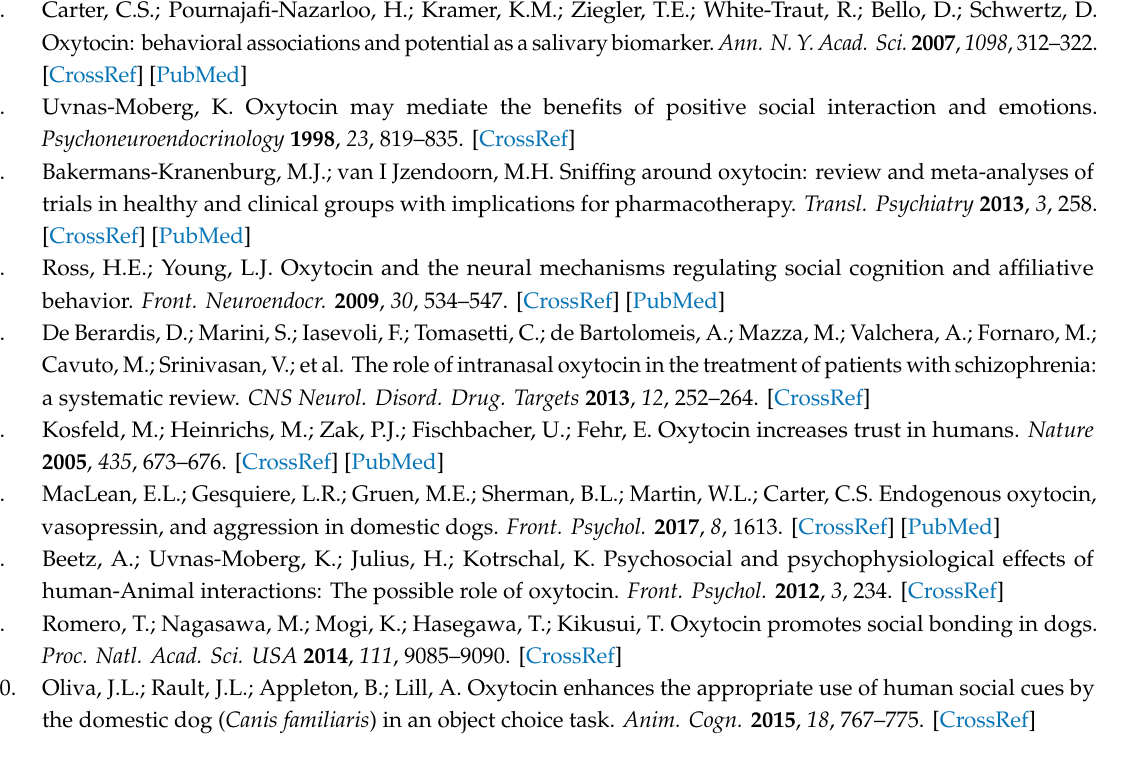
Figure S1: OT signals in MS using di ff erent mobile phase additives, Figure S2: Calibration standard curve of OT, Table S1: LC